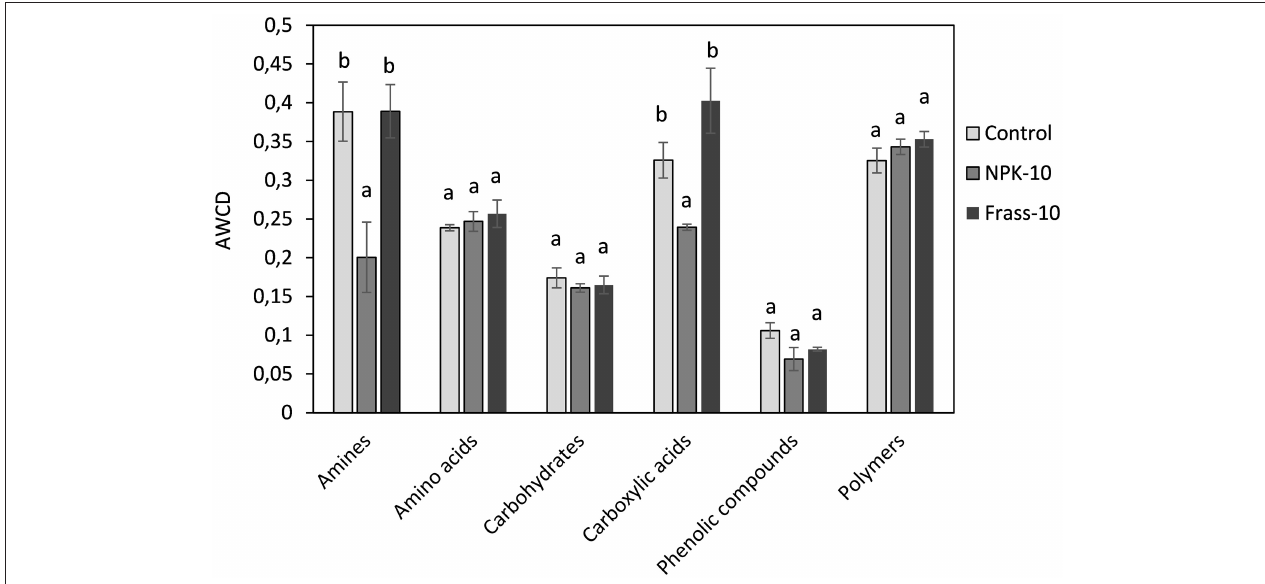
FIGURE 4 | Average well-color development (AWCD) for each group of substrates metabolized in BIOLOG EcoPlate. Values are average ( n = 3) ± standard error. Columns with same letter do not differ significantly at the 5% level.